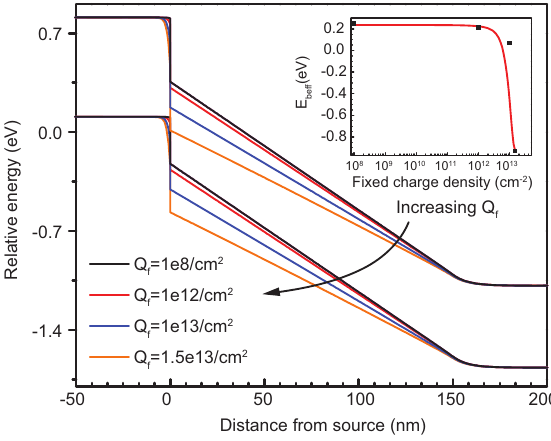
Sb /In Ga As 0.35 0.65 0.7 0.3